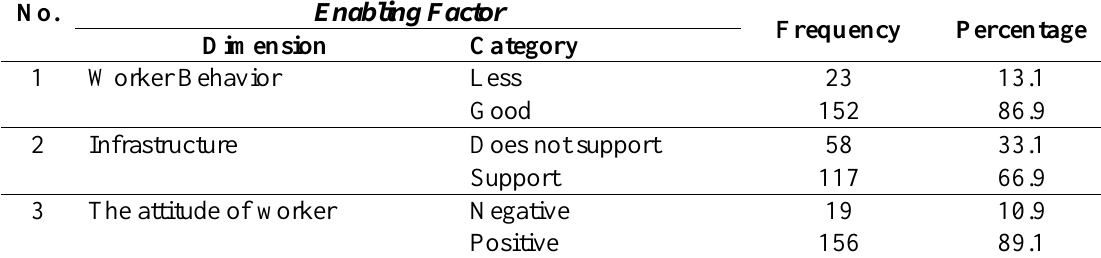
Table 2. Distribution of Respondent based on Enabling Factor at Puskesmas, Surabaya, 2016 No.